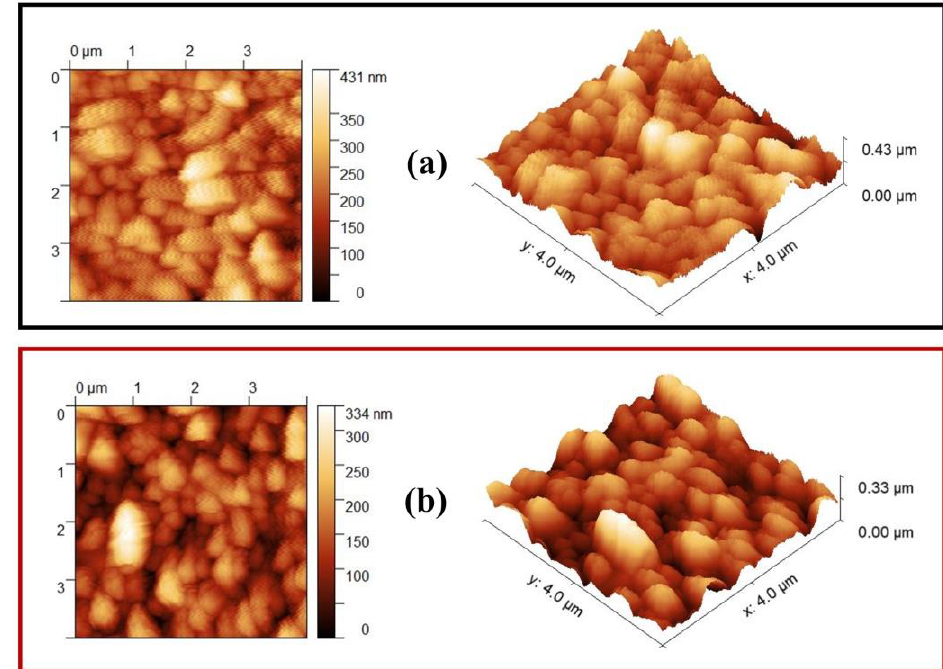
Figure 7. AFM images of ( a ) NiO x and ( b ) 5% Zn-NiO x thin films.